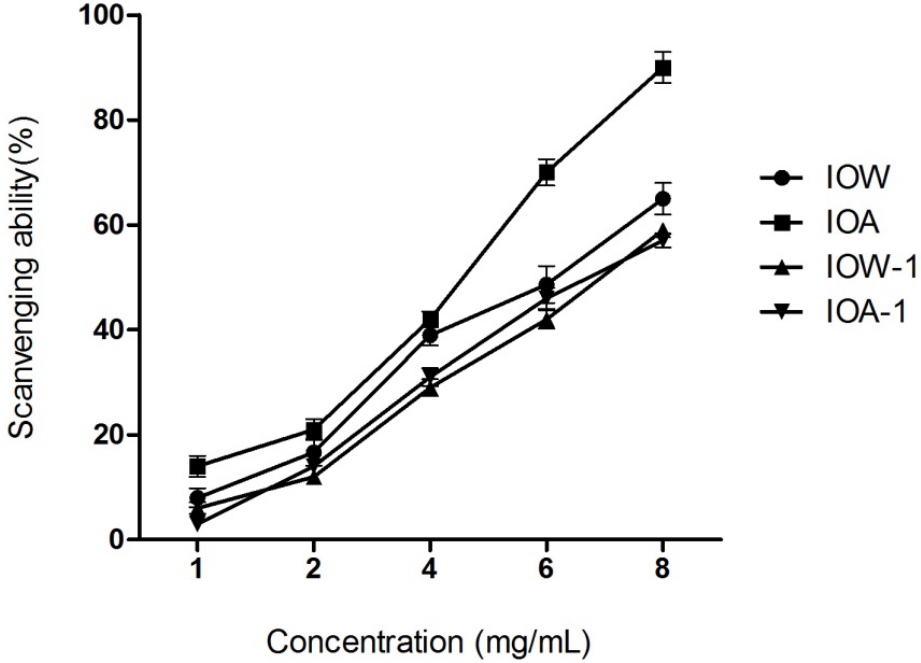
Figure 2. Scavenging ability on hydroxyl